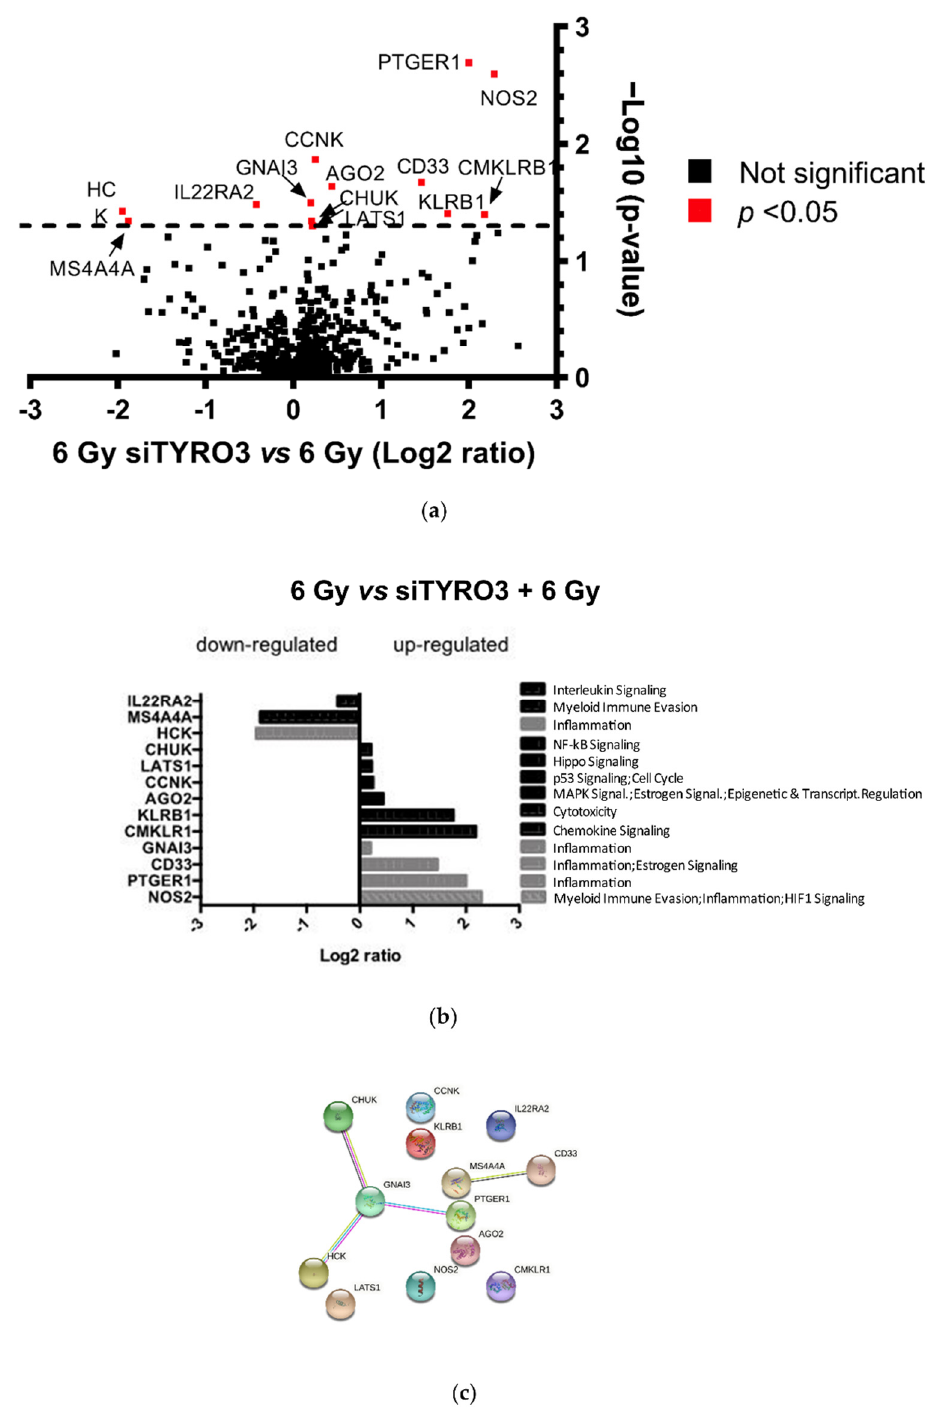
Figure 3. TYRO3 modulation and its impact on DNA damage response pathways. ( a ) Volcano plot showing the fold change (Log2 Ratio) versus negative log of the p-value of differentially expressed genes after Nanostring analysis between BCa (RT112 and 5637) 6 Gy irradiated cells versus BCa 6 Gy irradiated cells after complete TYRO3 knock-down (siTYRO3#4 and siTYRO3#801). Significant: p -value < 0.05. ( b ) Log2 ratio of the significantly expressed genes ( p < 0.05) after Nanostring analysis between the two groups. The name of the up- or downregulated genes are listed on the left. On the right are the corresponding Nanostring gene annotations. ( c ) Protein-protein association network of the up and downregulated genes assessed using the STRING